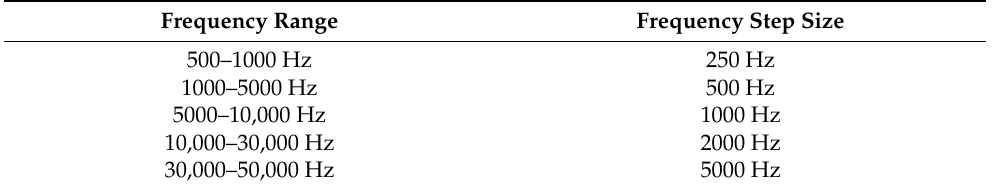
Table 3. Experimental